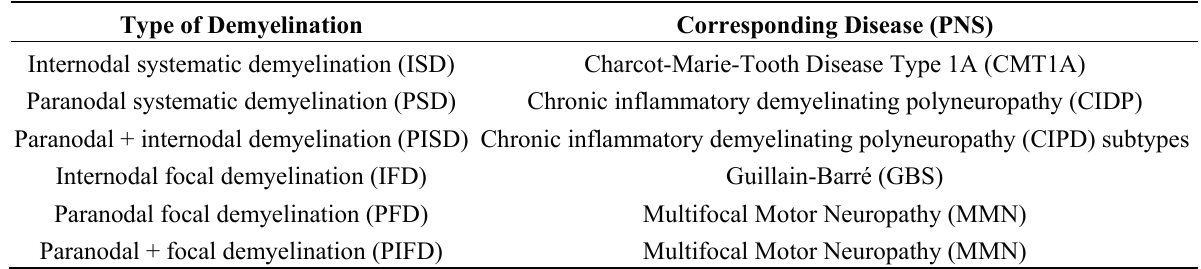
Table 1. Correspondence between types of demyelination and diseases according to Stephanova and Dimitrov